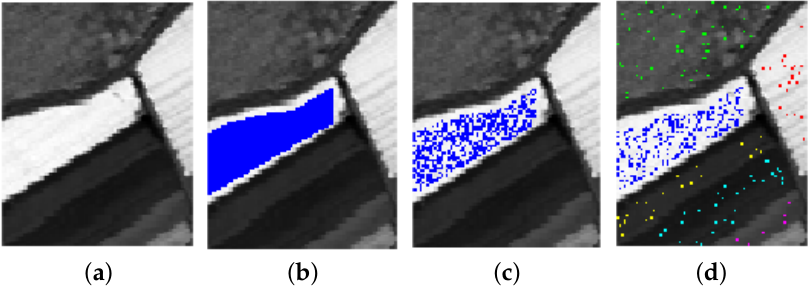
Figure 3. An illustration of introducing label noise. ( a ) the first PC of Salinas Scene ; ( b ) labelled samples in Class 1 (marked in blue); ( c ) training samples (50% of the labelled samples) in Class 1 and ( d ) an instance of the samples labelled as Class 1 when ρ = 0.5. Different colors denote samples from different classes that were erroneously flipped to Class 1.